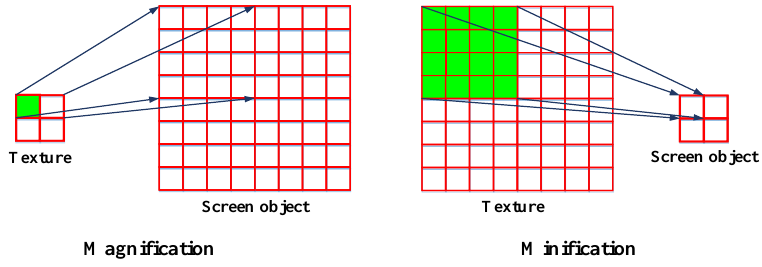
Figure 23. Filtering methods for adapting a texture image to the screen resolution.